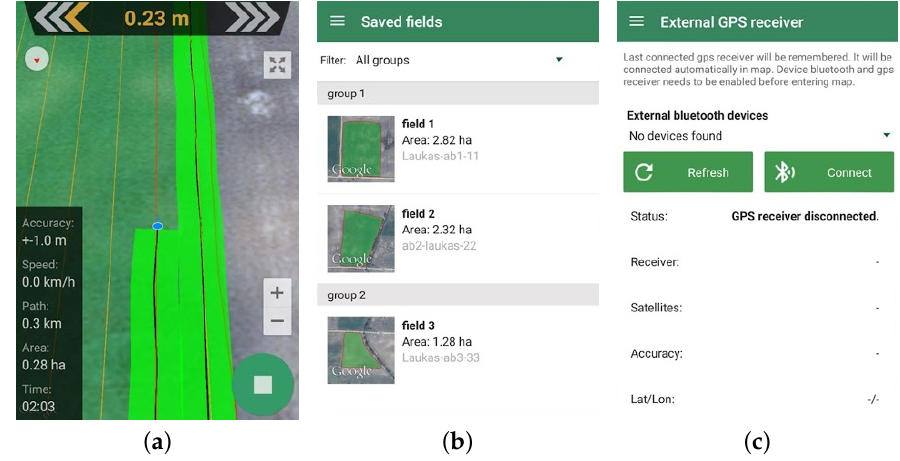
Figure 36. Field Navigator: ( a ) Navigation interface; ( b ) Land history for future use; ( c ) Connect external GPS